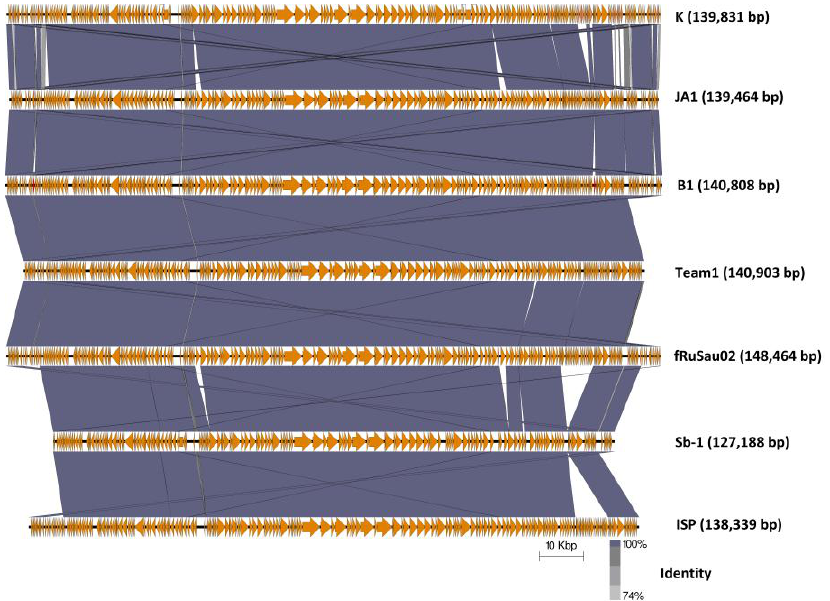
Figure 3. Genome comparison of phage K with the six staphylococcal phages employed in commercial phages mixture (B1, JA1, Team 1 [22–24], vB_SauM-fRuSau02 [21], Sb-1 [19] and ISP [20]) using